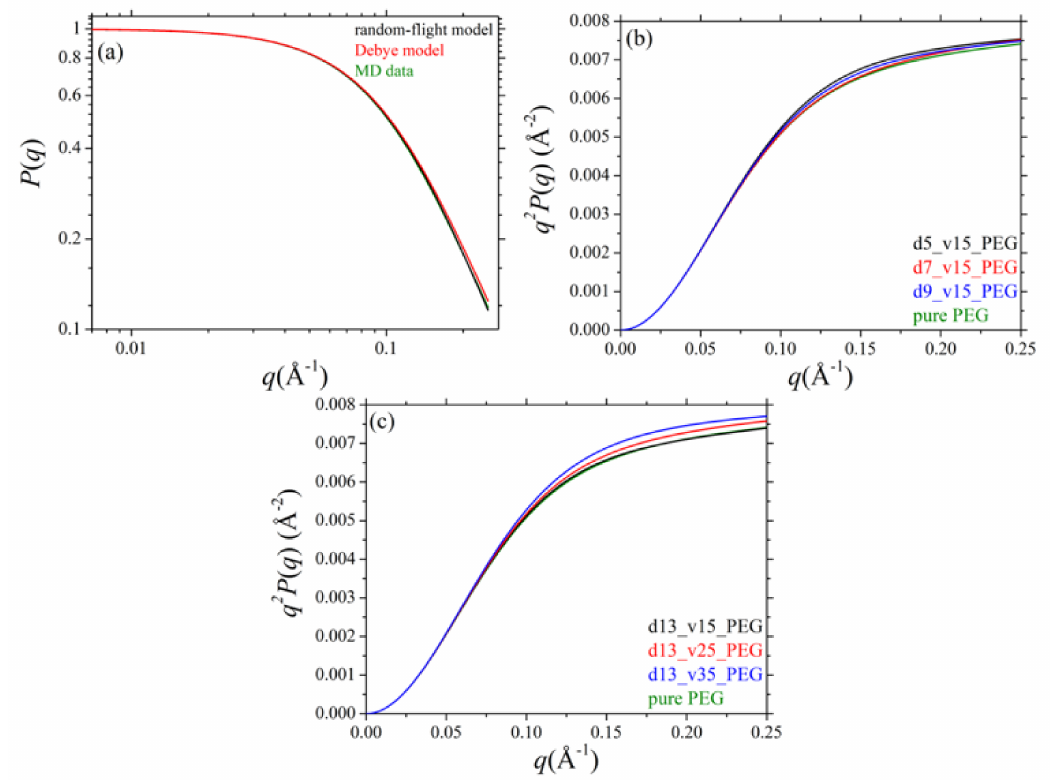
Figure 6. ( a ) MD predictions for the single chain form factor, P ( q ), of pure PEG melt ( T = 413 K and p = 1 atm), and the respective predictions provided by the random-flight model and the Debye equation. ( b ) Kratky plots ( q 2 P ( q ) versus q ) for all systems studied (pure PEG and PEG-silica nanocomposites) and dependence on silica nanoparticle size. ( c ) Kratky plots ( q 2 P ( q ) versus q ) for all systems studied (pure PEG and PEG-silica nanocomposites) and dependence on the volume fraction of